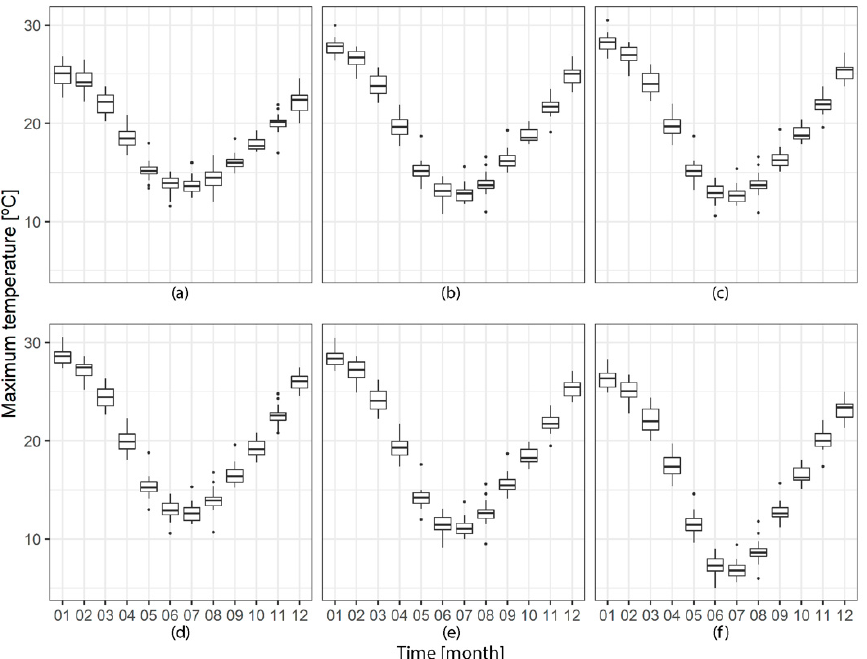
Figure A2. Box-plot of maximum temperature per month for the agro-climatics areas of Biobio: ( a ) Secano Costero, ( b ) Secano interior, ( c ) Depresión Intermedia, ( d ) Cordón Isla, ( e ) Precordillera and ( f ) Cordillera.